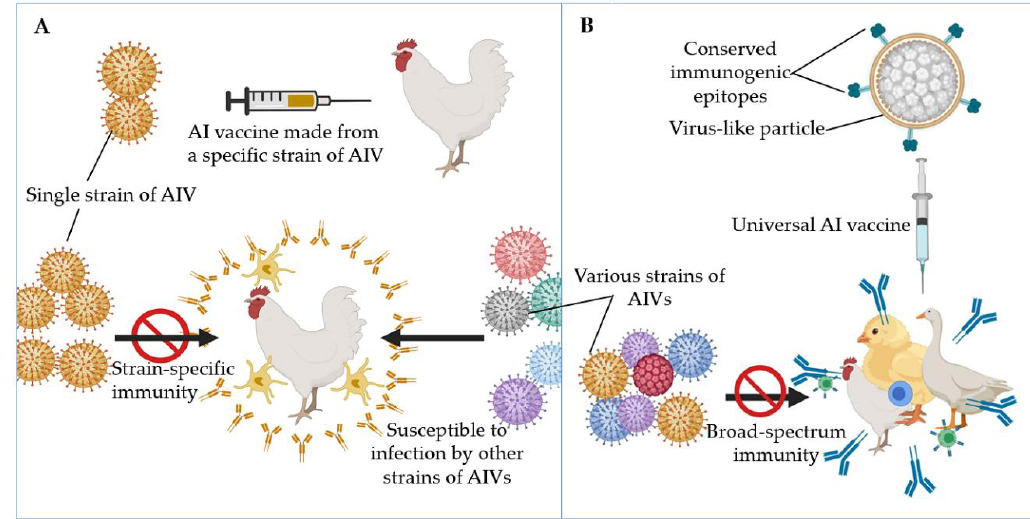
Figure 2. Immunogenicity of strain-specific avian influenza (AI) vaccines versus universal AI vaccines. ( A ) Vaccines derived from specific strain(s) of avian influenza viruses (AIVs) confer strain-specific immunity in vaccinated animals. ( B ) Universal AI vaccines harbouring M2e and/or headless haemagglutinin (HA) stalk confer broad-spectrum immunity in vaccinated animals. This is because the M2e and HA stalk components of these vaccines are conserved across all strains of AIVs.